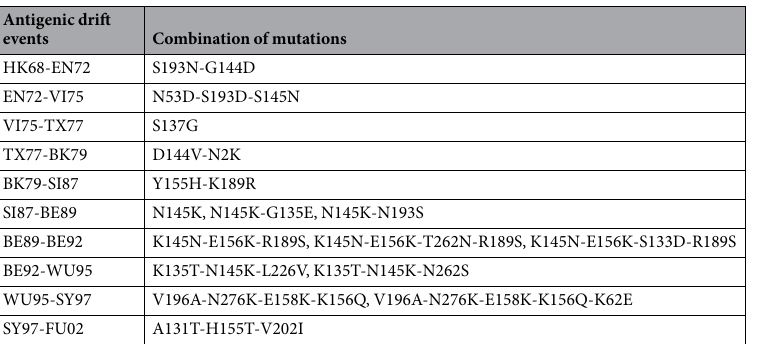
Table 4. Multiple mutations driving 10 antigenic drifts for H3N2 influenza viruses inferred by